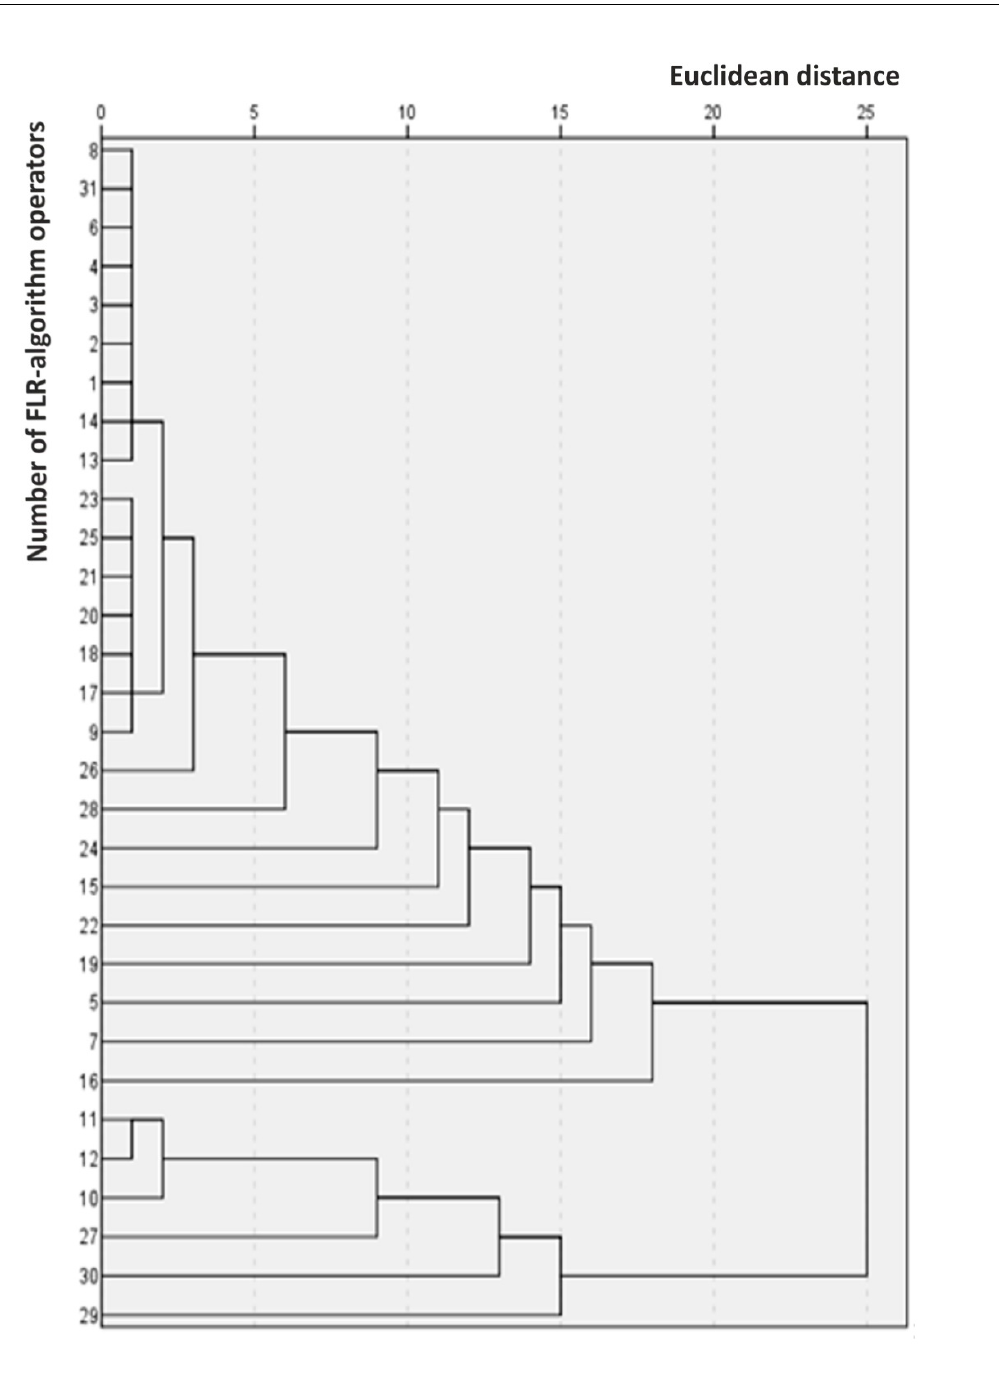
Figure 7. Intra-group connections dendrogram for FLR-algorithm.